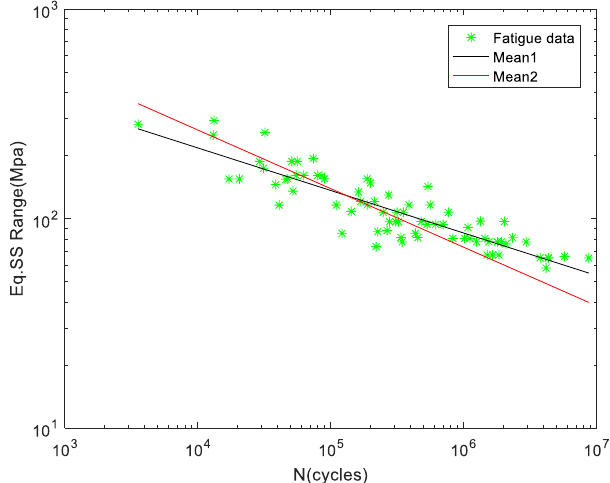
Figure 10: Master S-N curve based on Eq. SS Range.